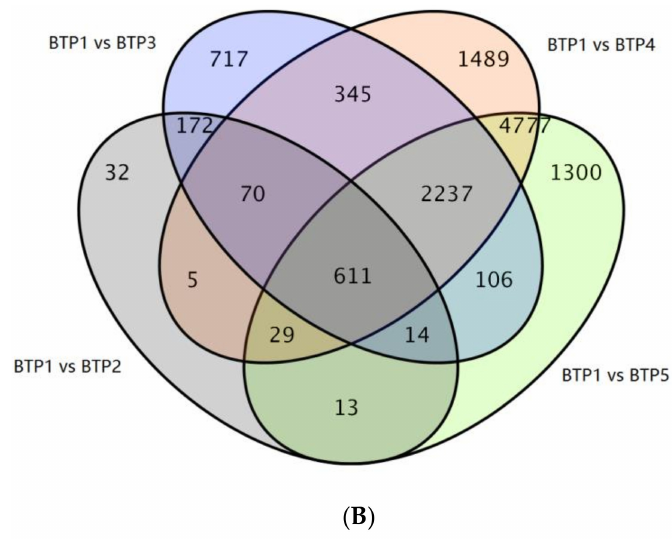
Figure 5. Differentially expressed genes at various stages of BTP flower development ( A ) DEGs among BTP1 vs. BTP2, BTP1 vs. BTP3, BTP1 vs. BTP4, and BTP1 vs. BTP5. Blue: up–regulated expression of DEGs, Red: down–regulated. ( B ) Venn Diagram of DEGs between 4